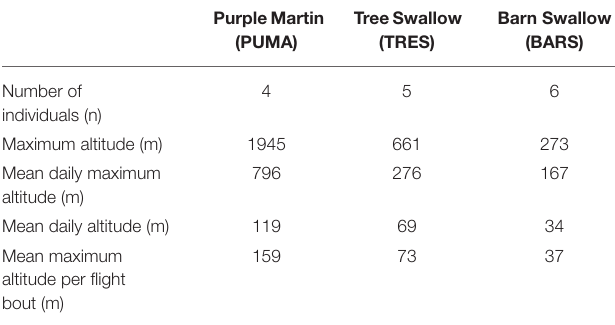
TABLE 1 | Summary of individual flight bout data.